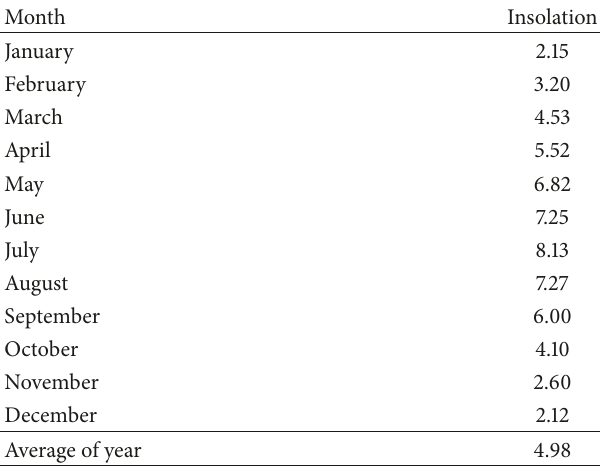
Table 2: Average daily solar insolation (kWh/m 2 /day) in Huelva order by month.